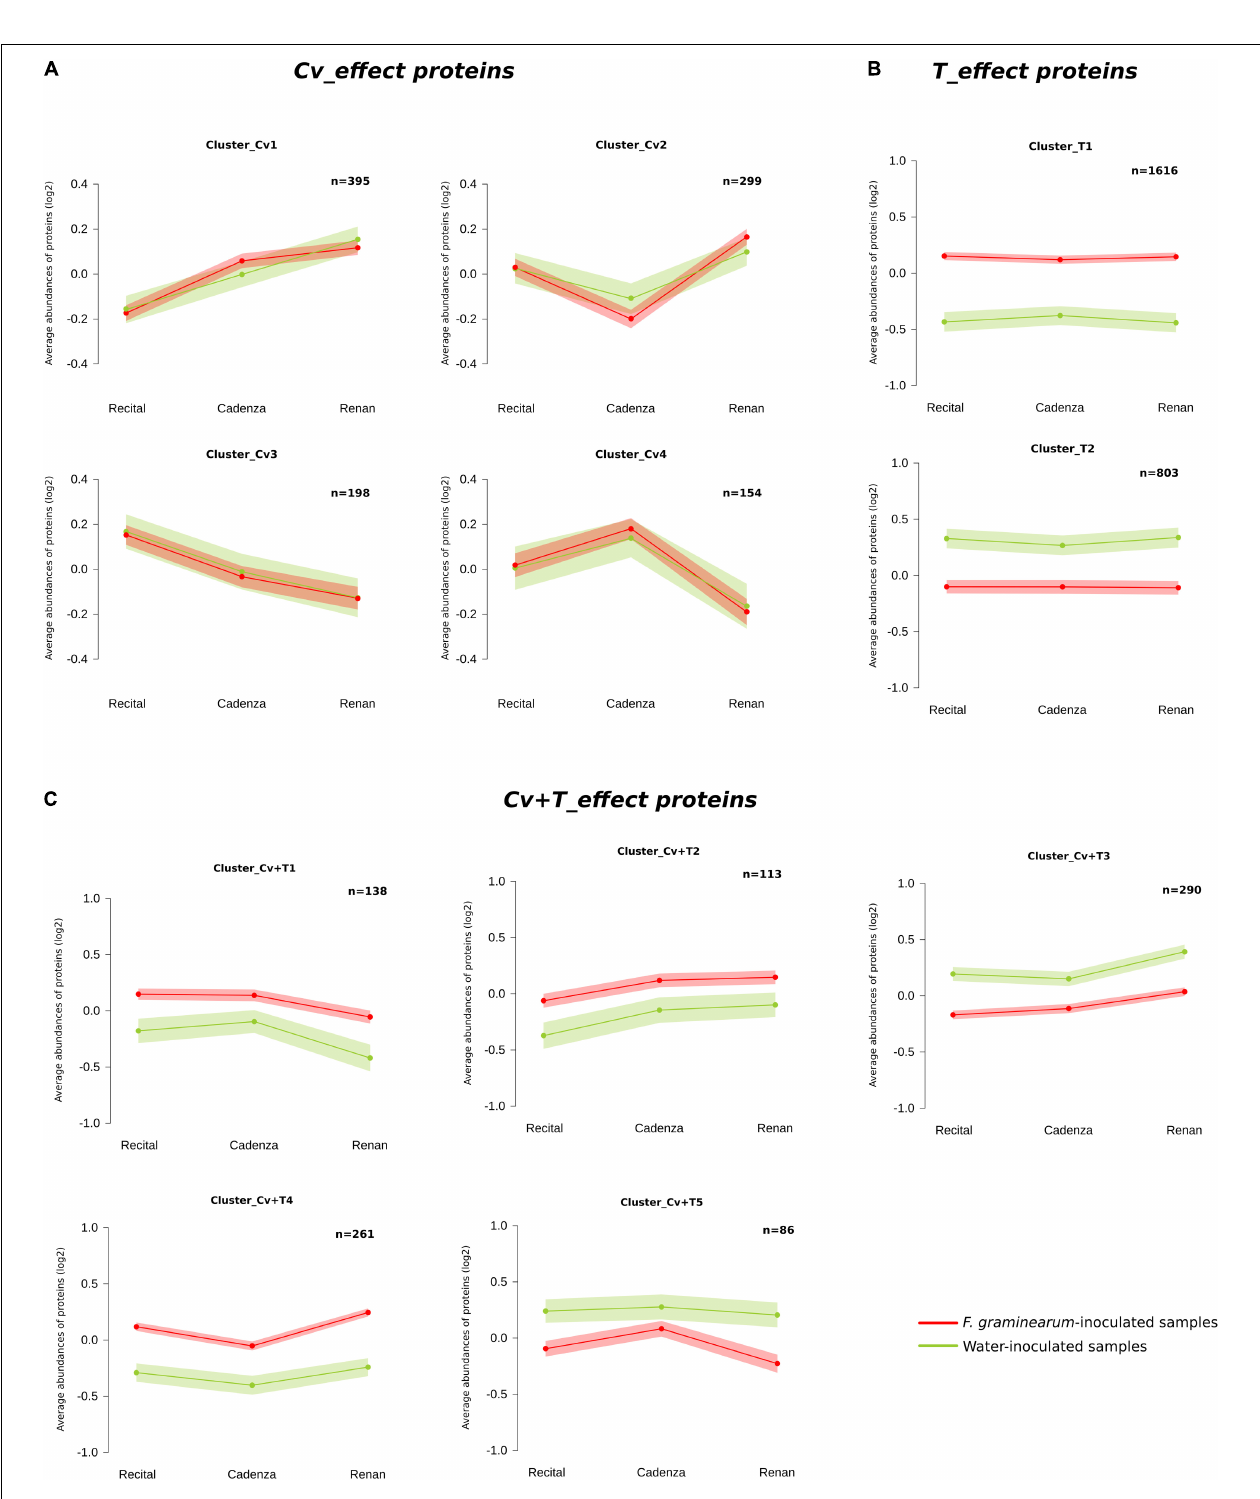
FIGURE 4 | Clustering representation of the wheat proteins displaying basal differences between wheat cultivars and generic responses upon Fusarium graminearum inoculation. Clustering was computed using the fuzzy C-means method from Z -score transformed values to identify homogeneous patterns in (A) Cv_effect proteins, (B) Treatment_effect proteins, and (C) Cultivar + Treatment_effect proteins. For each protein cluster, the average profile was represented by the line plot with the wheat cultivars on the x -axis and the normalized abundances on the y -axis. A color code was given for the two treatment modalities: red : average protein abundances observed in F. graminearum -inoculated samples; green : average protein abundances observed in the water-inoculated samples. The number of proteins in each cluster is indicated in the upper right-hand corner of the graphs ( n ). Ribbons indicate the 95% confidence interval and retain the same color code.